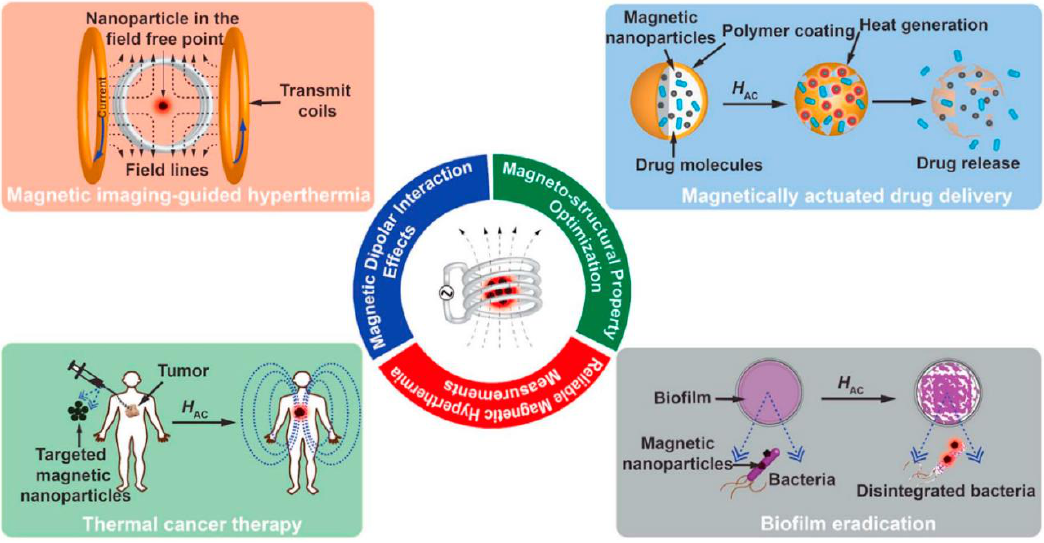
Figure 3. Schematic representation of multifunctional capabilities of magnetic nanoparticles for various types of biomedical applications, reproduced from [65], Elsevier, 2011.